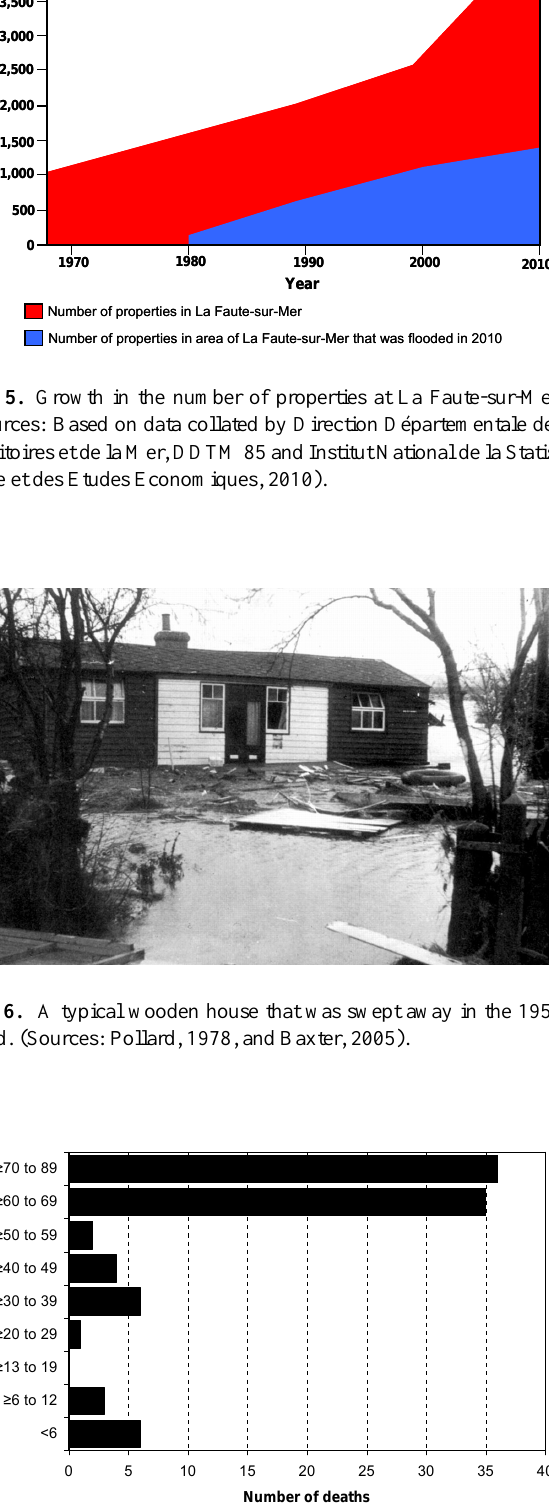
Fig. 8. Age of the people who died in the 1953 floods at Canvey Island and Jaywick. (Source: Based on data in Grieve, 1959).